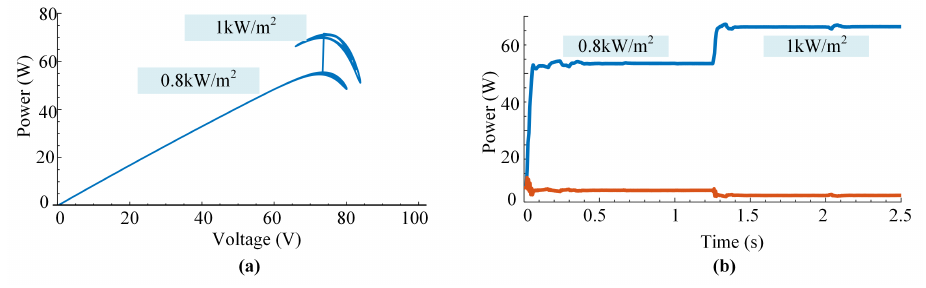
Figure 11. ( a ) P − V curve of MPPT. ( b ) Changes in active and reactive power under irradiation.